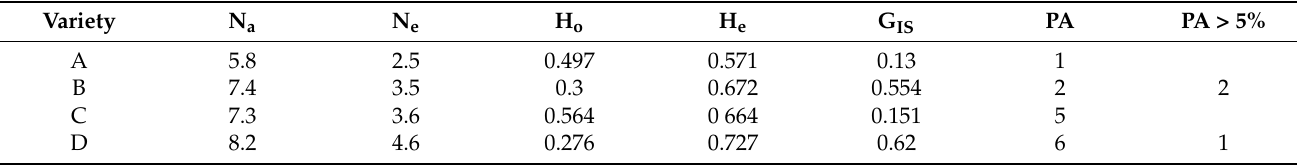
Table 4. Descriptive statistics of genetic diversity calculated for each of the 14 varieties analyzed. The mean number of observed (N a ) alleles, the mean number of effective (N e ) alleles, observed heterozygosity (H o ), expected heterozygosity (H e ), Wright’s inbreeding coefficient (G IS ), private alleles (PA) for each variety, and private alleles with a frequency higher than 5% are reported for each